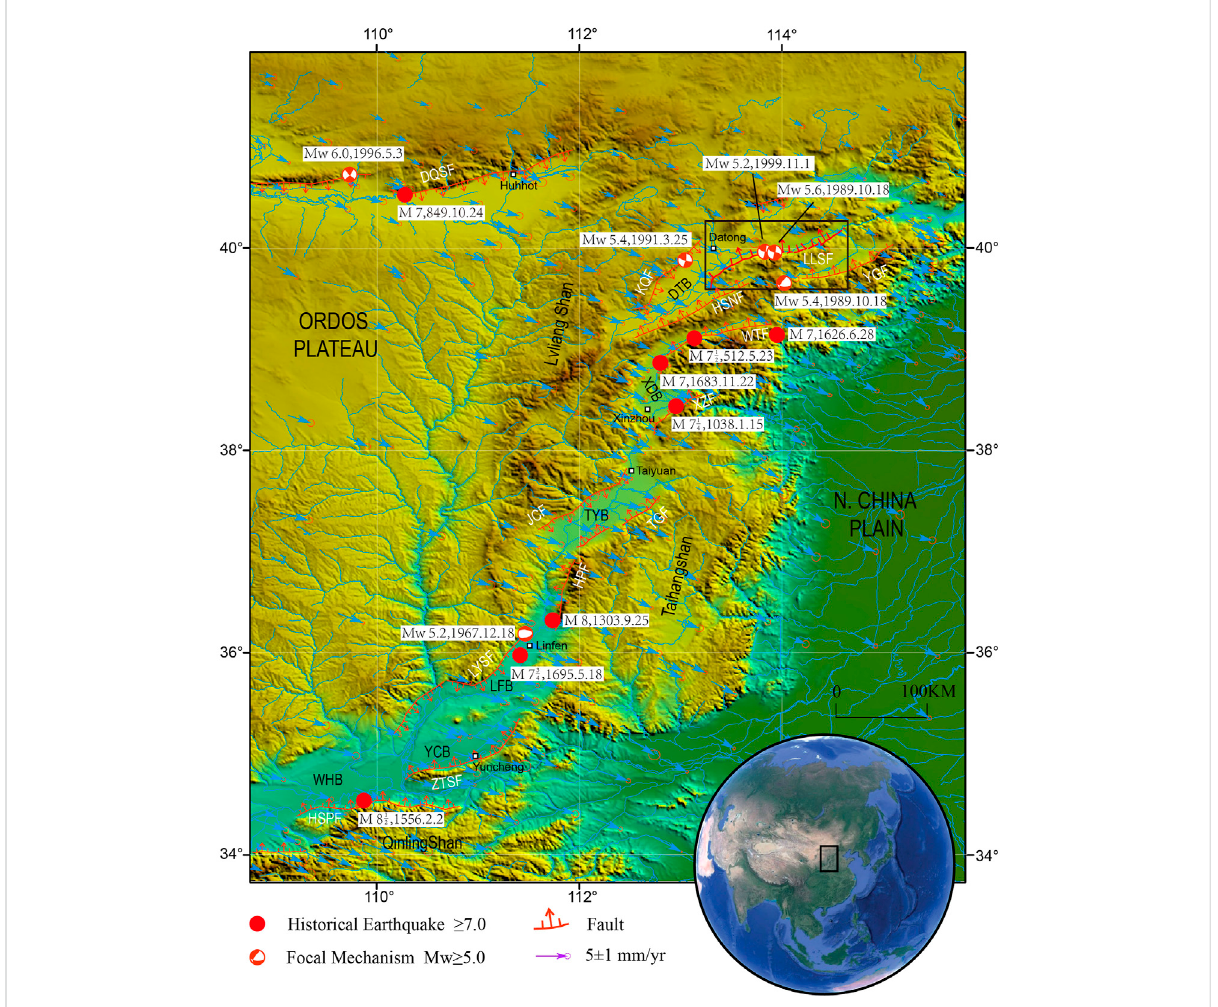
FIGURE 1 Shuttle Radar Topography Mission (SRTM) topography of the Shanxi Rift system in North China. The red lines and red circles represent major activefaultsandmajorhistoricalearthquakeswithmagnitudesgreaterthanM7,respectively(WorkingGrouponHistoricalEarthquakeCompilationof Shanxi Province Earthquake Administration, 1991). Horizontal GPS (global position system) velocities relative to the stable Eurasian plate (Wang and Shen, 2020), focal mechanisms of instrumental earthquakes with Mw > 5 (CMT catalog, Ekström et al., 2012). Inset globe shows the location of Figure1withAsia.Majorfaultedbasinsandfaults:WHB,WeiheBasin;YCB,YunchengBasin;LFB,LinfenBasin;TYB,TaiyuanBasin;XDB,XindingBasin; DTB, Datong Basin; HSPF, Huashan Piedmont Fault; ZTSF, Zhongtiaoshan Fault; LYSF, Luoyunshan Fault; HPF, Huoshan Piedmont Fault; JCF, JiaochengFault;TGF,TaiguFault;XZF,XizhoushanFault;WTF:WutaishanFault;HSNF:HengshanNorthernFault;YGF,YangyuanGrabenFault;KQF, Kouquan Fault; DQSF, Daqingshan Fault; and LLSF, Liulengshan